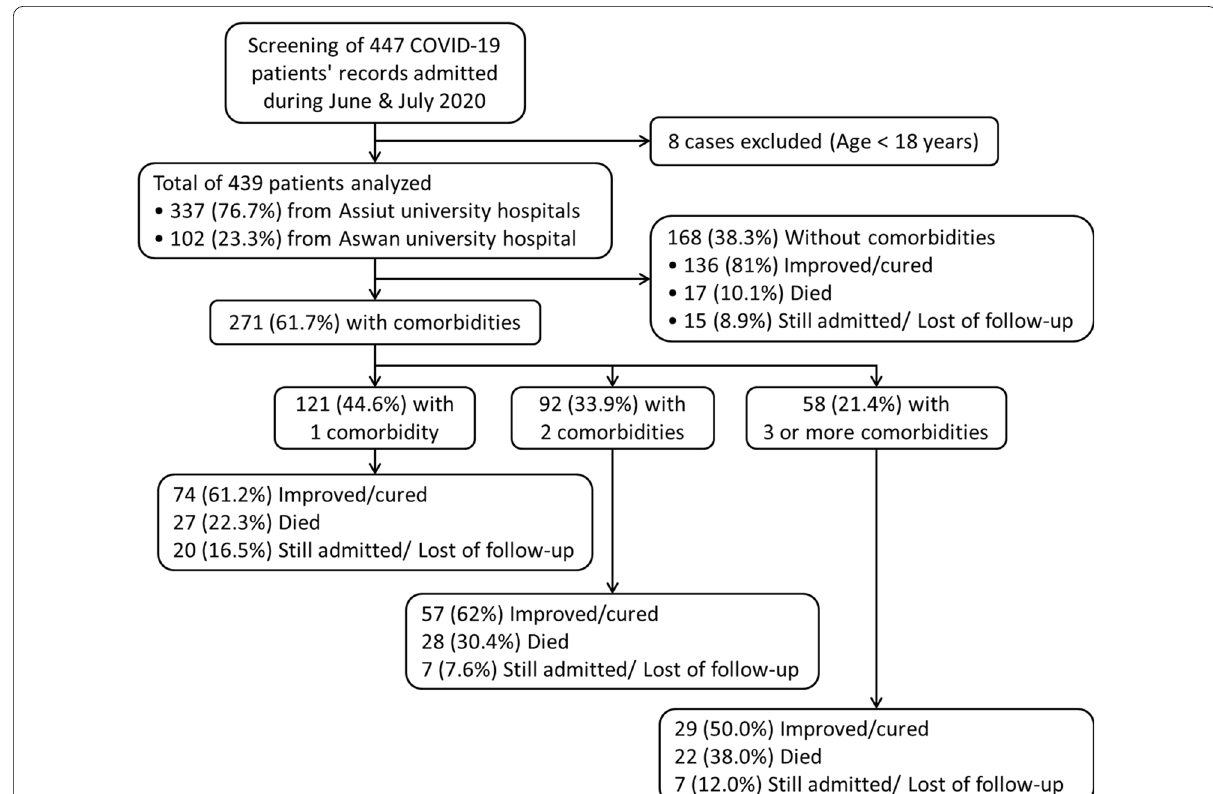
Fig. 1 Flowchart of COVID‑19 patients included in the study stratified according to number of